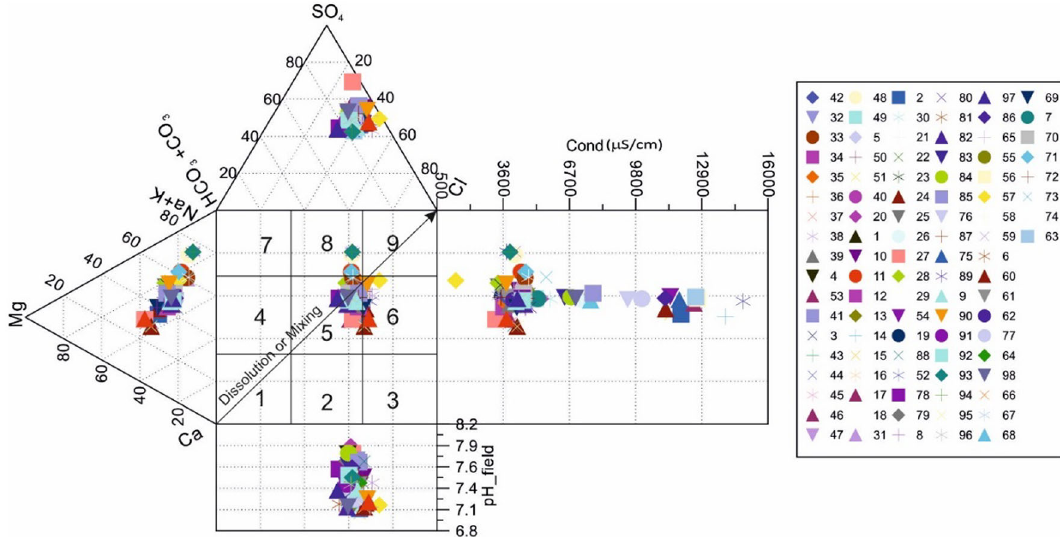
Fig. 9 Chemical facies of groundwater in Durov diagram of the present study